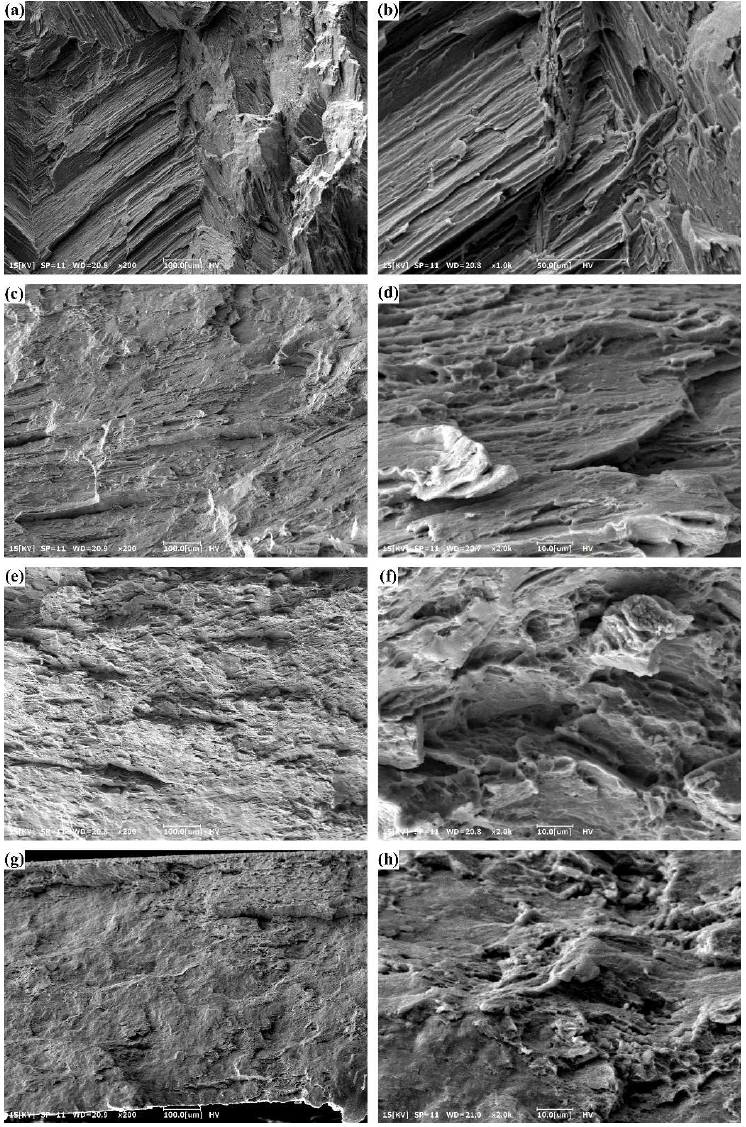
Figure 8. Fracture surfaces of ( a , b ) as-cast alloy; ( c , d ) R30 alloy; ( e , f ) R50 alloy; and ( g , h ) R70